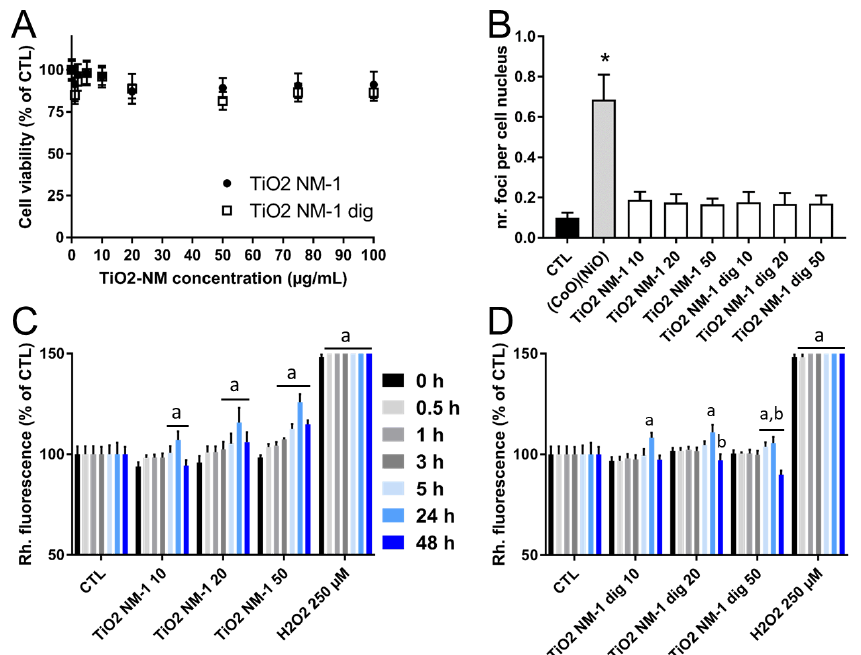
Figure 10. Toxicity of untreated and digested TiO 2 -NM1. Cytotoxicity of TiO 2 -NM1 assessed using the WST-1assay( A );genotoxicityassessedusing53BP1immuno-labellingandfocicount( B );oxidativestress assessed via DHR123 assay ( C ). Cells were exposed for 24 h ( A , B ) or 0.5 to 48 h ( C , D ) to pristine or digested TiO 2 -NM1. Positive control: 100 µ g / mL PS-NH 2 , resulting in 80% decrease of metabolic activity in the WST-1 assay (not shown), 250 µ M H 2 O 2 in the DHR123 assay, 100 µ M etoposide in the 53BP1 assay. Statistical significance: a: p < 0.05, 0.5 or 1 or 3 or 5 or 24 or 48 h vs. 0 h; b: p <